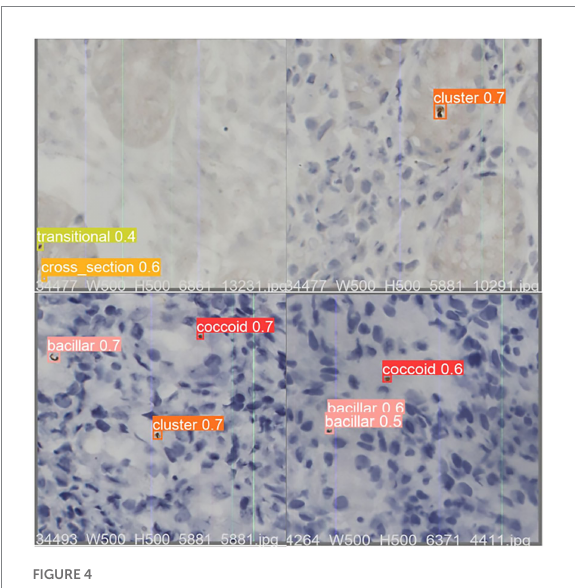
FIGURE 4 An example of optimized YOLO v5 detection result on test dataset sample images. The value shown in the image is the Intersection over Union (IOU), which measures the correlation between true and predicted as an evaluation function. The IOU is between 0 and 1, with higher values being more relevant. Any prediction above 0.5 is usually considered correct. IOU, area of overlap/area of union.